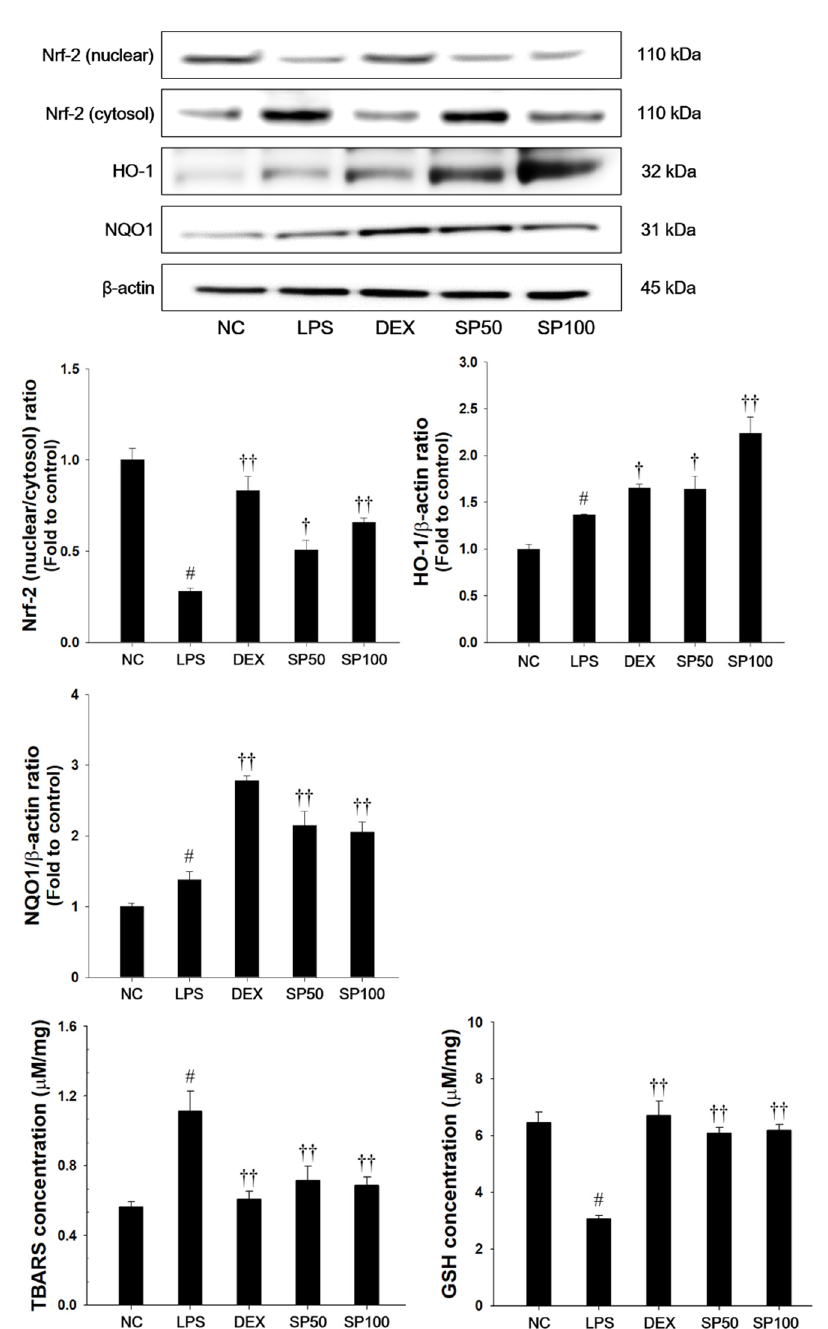
Figure 5. Effects of SP on Nrf2 pathways, lipid peroxidation and glutathione (GSH) in LPS-induced ALI mice. The protein levels of Nrf-2, HO-1, and NQO1 in the lung tissues were assessed by western blot analysis. β -actin was used to confirm equal protein loading. The levels of TBARS and GSH were measured in the lung tissues. NC: normal control mice; LPS: LPS-induced mice; DEX: dexamethasone (3 mg/kg) + LPS-induced mice; SP 50: (50 mg/kg) + LPS-induced mice and SP 100: (100 mg/kg) + LPS-induced mice. The values are expressed as the means ± SD ( n = 7/group). # Significantly different from NC group, p < 0.05; †, †† significantly different from LPS-treated group, p < 0.05 and p < 0.01.